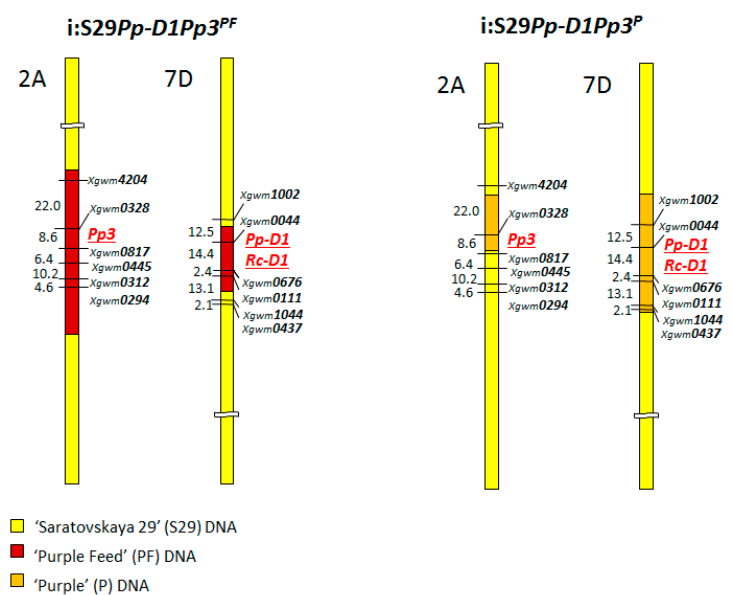
Figure A1. Schematic representation of introgressions from cvs Purple Feed and Purple into the wheat chromosomes 2A and 7D carrying the regulatory Pp genes determining purple grain color which were used as donor lines for breeding anthocyanin-rich cultivars according to Tereschenko et al. (2012).